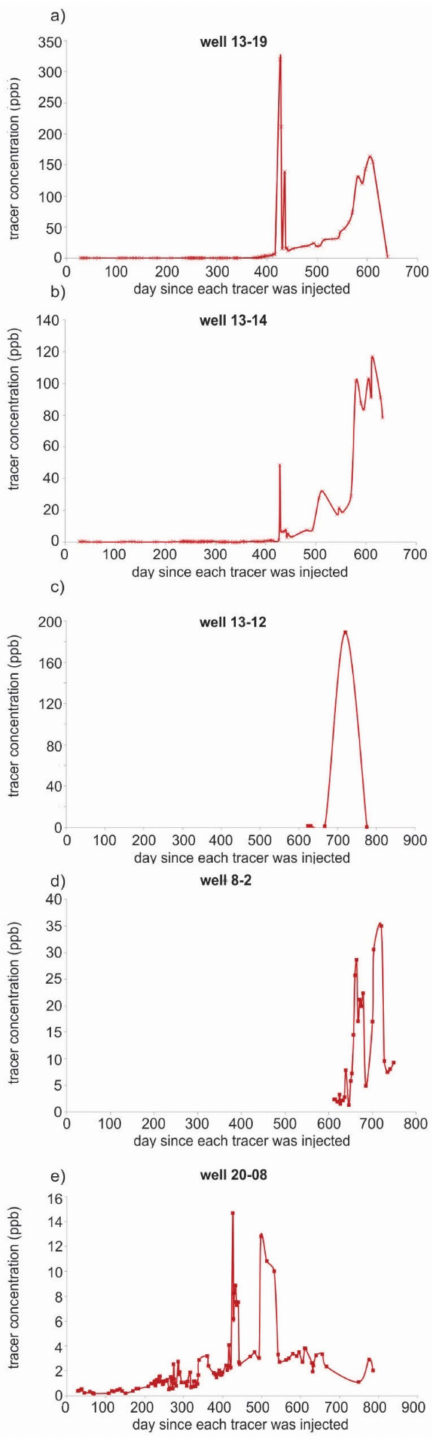
Figure 10. ( a ) Tracer 2,7-nds concentrations measured in well 13–19. 100 kg of this tracer was injected into water-injection well 14-1 on 13 October 2015; ( b ) 2,7-nds concentrations measured in well 13-14; ( c ) 2,7-nds concentrations measured in well 13-12. A paucity of data points on this plot reflects the fact that this well was sampled infrequently; ( d ) 2,7-nds concentrations measured in well 8-2. The paucity of data points on this plot reflects the fact that this well was sampled relatively infrequently; ( e ) 2,7-nds concentrations measured in well